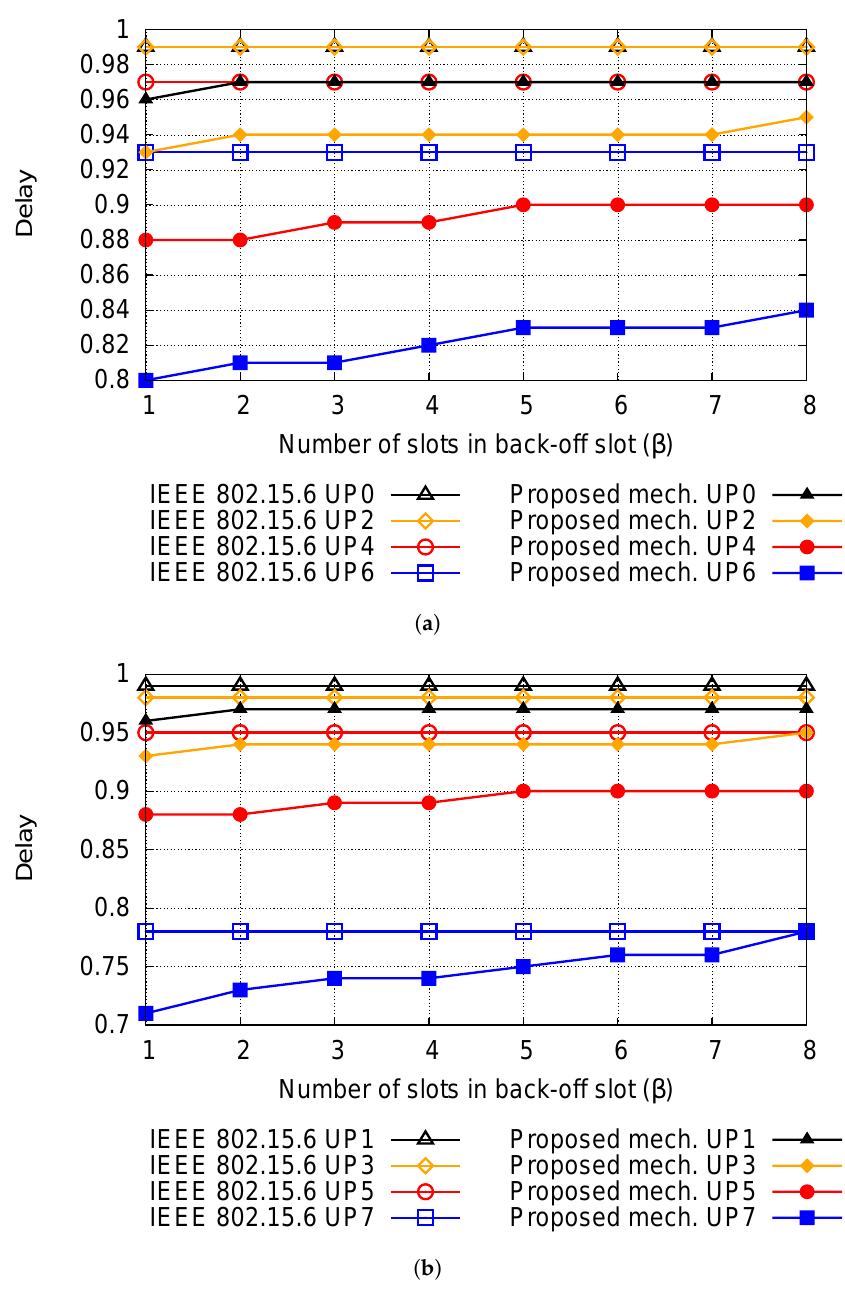
Figure 11. Delay comparison of IEEE 802.15.6 and proposed mechanism for different UP (Scenario 3). ( a ) Delay comparison for UP 0, 2, 4, and 6; ( b ) delay comparison for UP 1, 3, 5, and